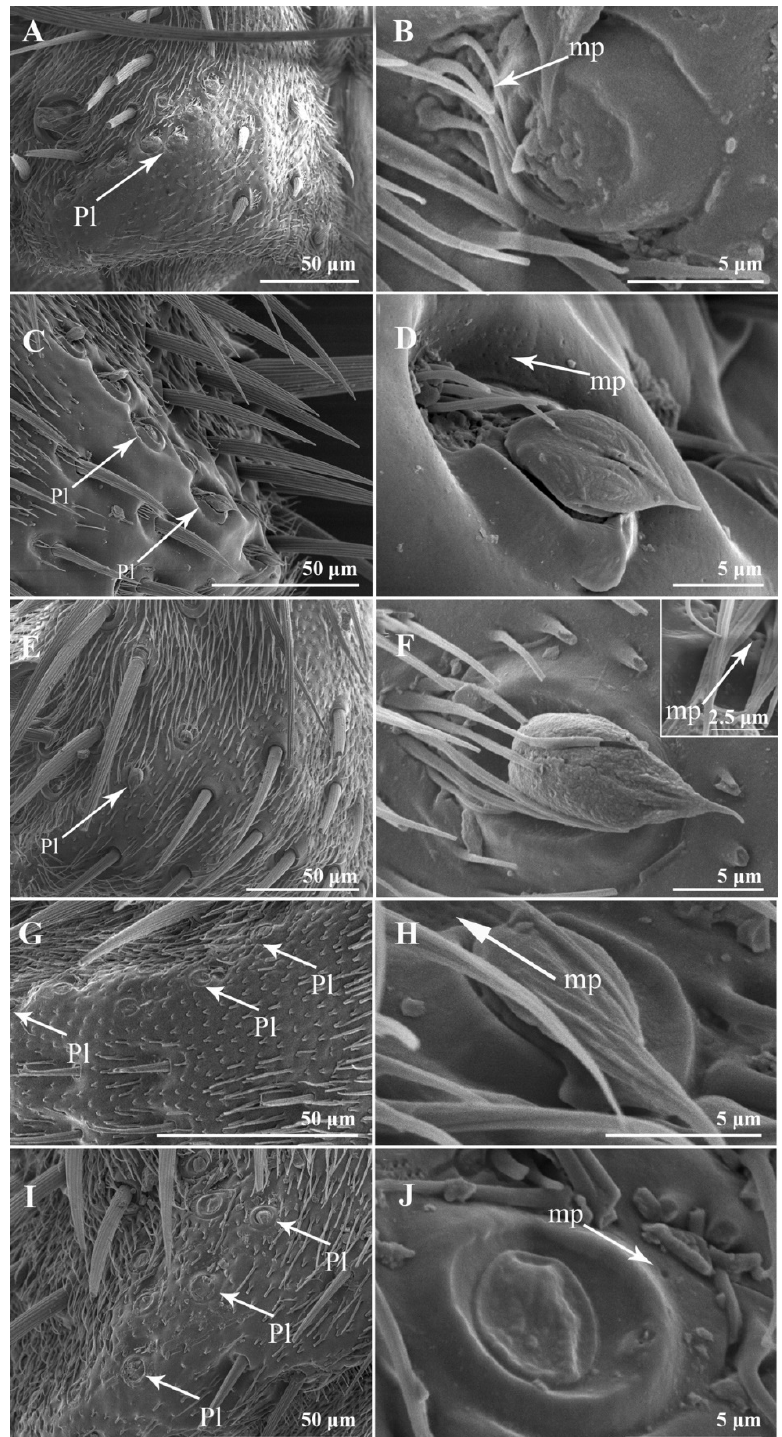
Figure 2. The setiferous plaques on the antennal pedicel of male S. albiceps , S. africa , S. peregrina , W. mag-nifica , and A. mihalyii . ( A , B ) S. albiceps , ( C , D ) S. africa , ( E , F ) S. peregrina , ( G , H ) W. magnifica , and ( I , J ) A. mihalyii . Abbreviations: mp (micropore); Pl (setiferous